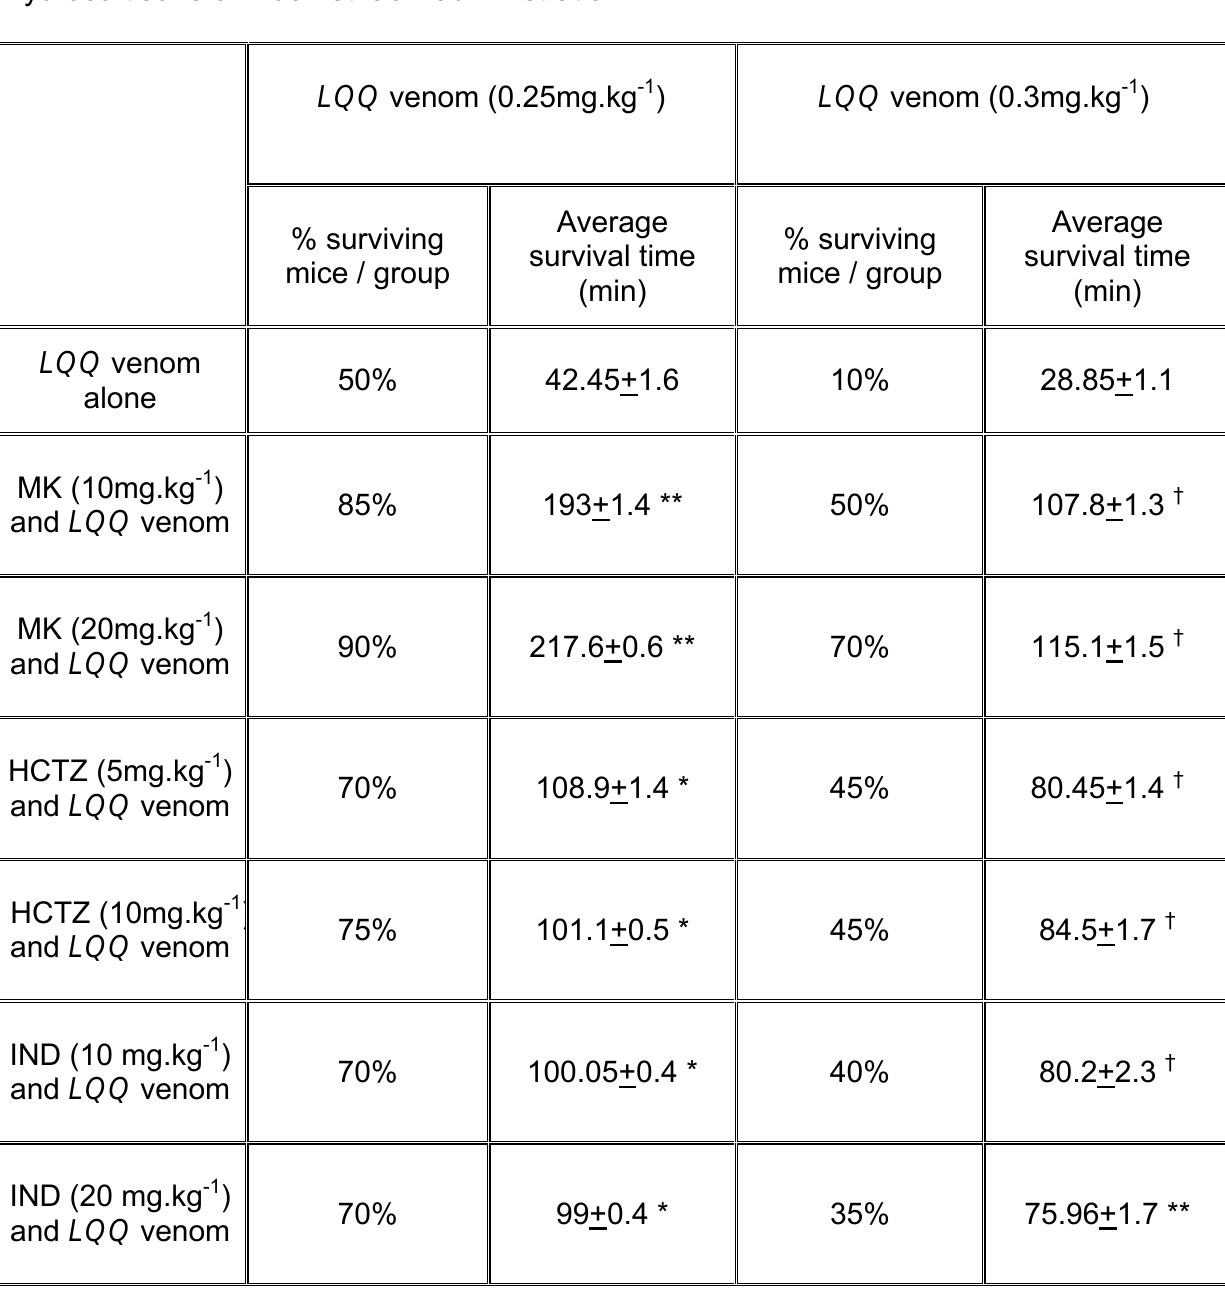
Table 1: Percentage of survival and average survival time of mice injected with Leiurus quinquestriatus quinquestriatus ( LQQ ) venom alone or after montelukast, hydrocortisone or indomethacin